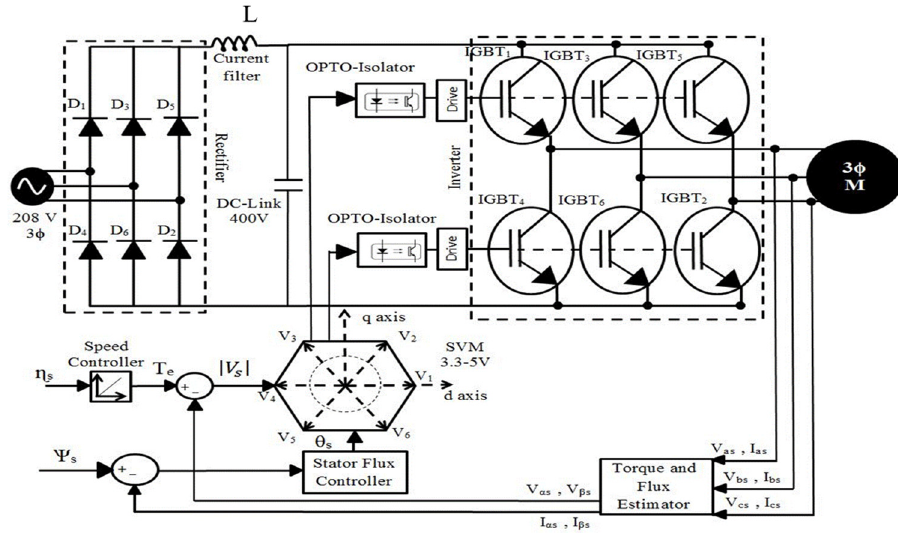
Figure 3. Direct power control of the induction motor (IM) based on sensor-less space vector modulation (SVM) applied to the VSDG.